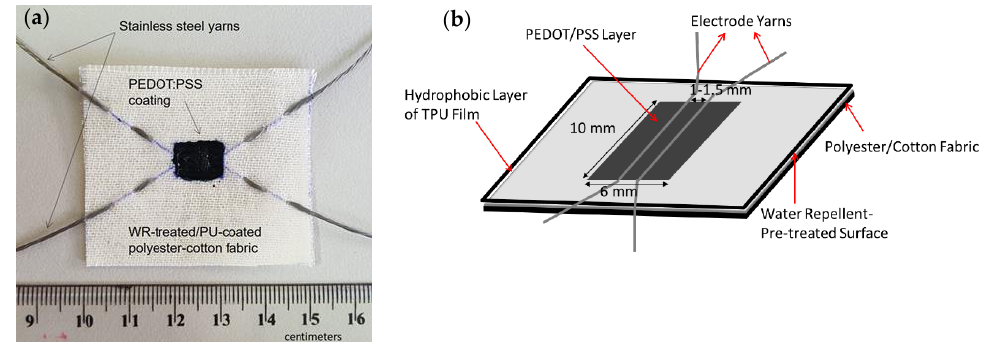
Table 1. Variation set up of the devices.